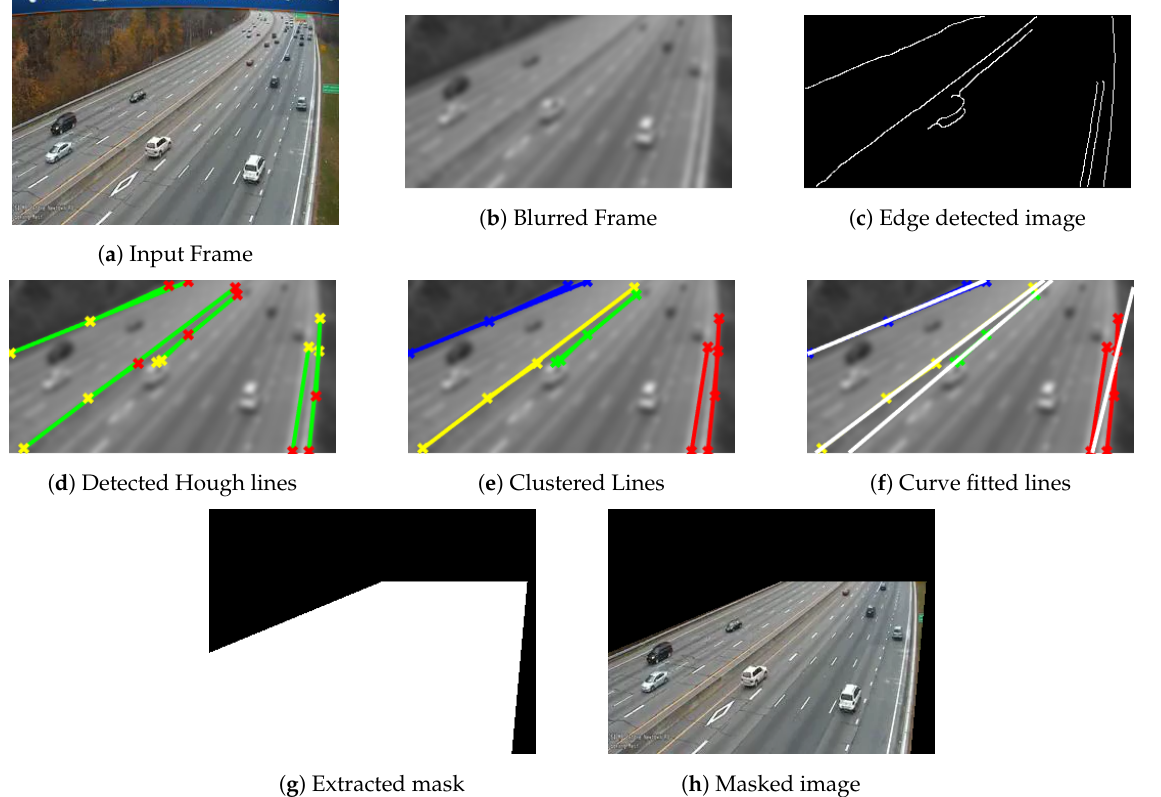
Figure 5. Different output for ROI extraction pipeline stages for Video